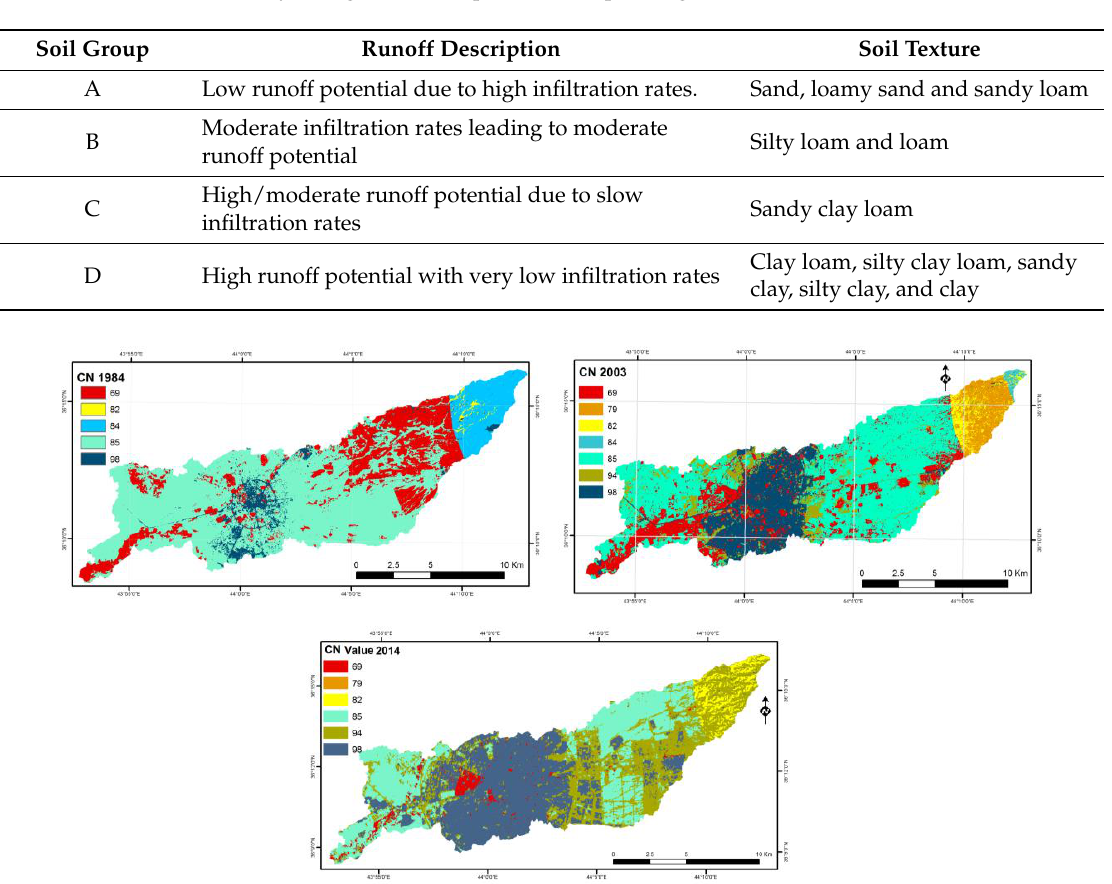
Table 1. Hydrologic Soil Groups and corresponding soil texture. From: [36].